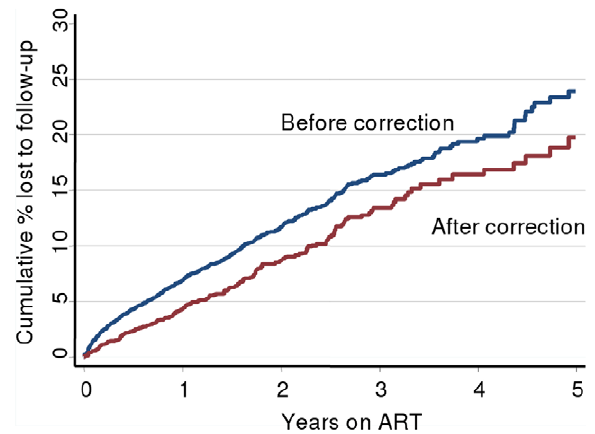
Figure 2. Cumulative probability of LTF before and after correction for mortality. Kaplan-Meier estimates of cumulative probability of loss to follow-up (LTF) before and after correction for mortality by ascertainment of vital status of patients lost to follow-up through the national vital registration system. Routine monitoring overestimated LTF by 4% at 5 years on ART (23.9 vs. 19.7%).